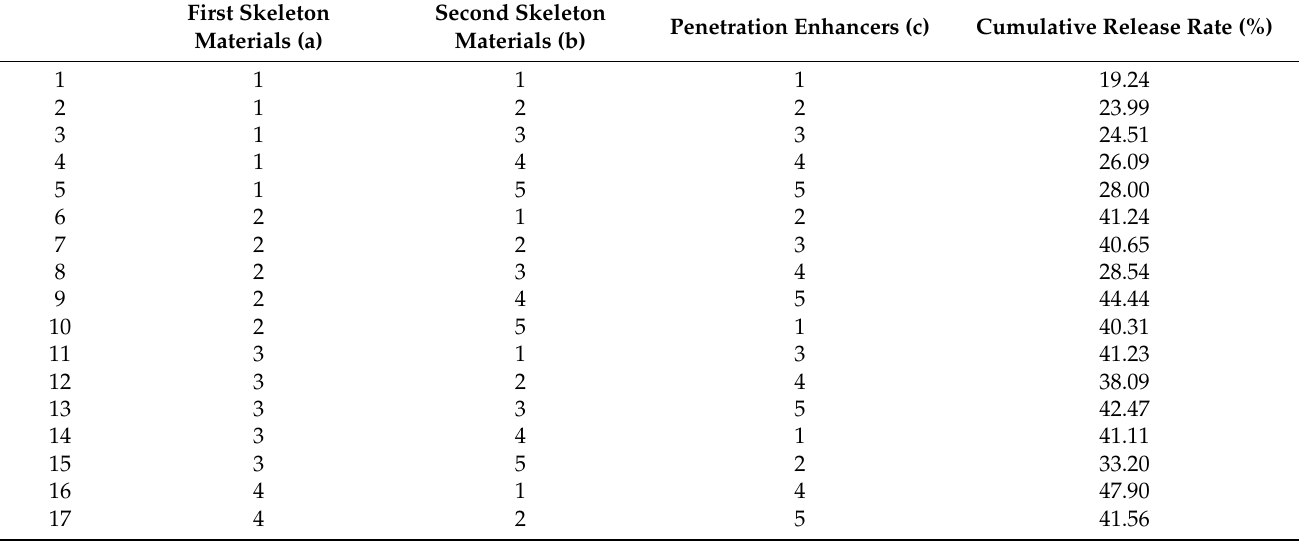
Table 1. L 25 (5 5 ) orthogonal